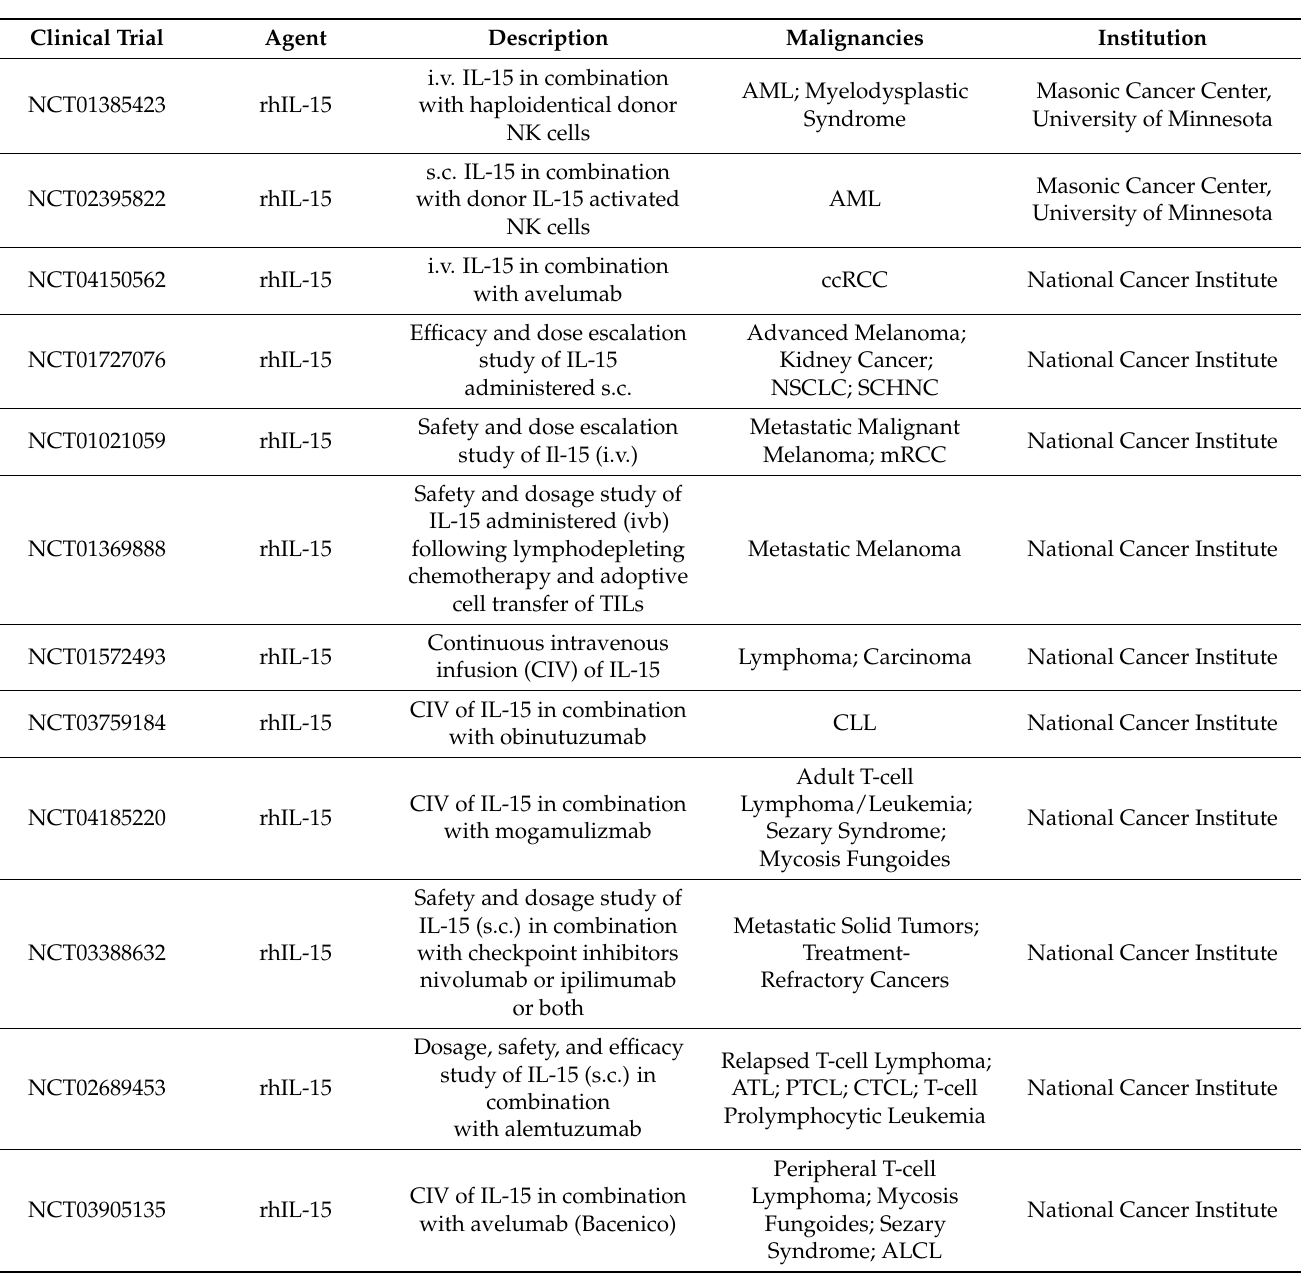
Table 3. Clinical trials of recombinant human IL-15 (rhIL-15) and its derivatives in cancer immunother- apy. i.v., intravenous; s.c., Subcutaneous; ivb, intravenous bolus; CIV, continuous intravenous infu- sion; BCG, Bacillus Calmette-Geurin. AML, acute myelogenous leukemia; ccRCC, clear-cell renal cell carcinoma; NSCLC, non-small cell lung cancer; SCHNC, squamous cell head and neck cancer; mRCC, metastatic renal cell cancer; CLL, chronic lymphocytic leukemia; ATL, adult T-cell leukemia; PTCL, peripheral T-cell lymphoma; CTCL, cutaneous T-cell lymphoma; ALCL, anaplastic large cell lymphoma; ALL, acute lymphoblastic leukemia; MDS, myelodysplastic syndromes; CML, chronic myelogenous leukemia; MM, multiple myeloma; GEJC, gastroesophageal junction cancers; HNSCC, advanced head and neck squamous cell carcinoma; NMIBC, non-muscle-invasive bladder cancer; mPC, metastatic prostate cancer; SCLC, small cell lung cancer; MCC, merkel cell carcinoma; NHL, non-Hodgkin lymphoma; CRC, colorectal carcinoma; sSCC, cutaneous squamous cell carcinoma; ASCC, anal cell